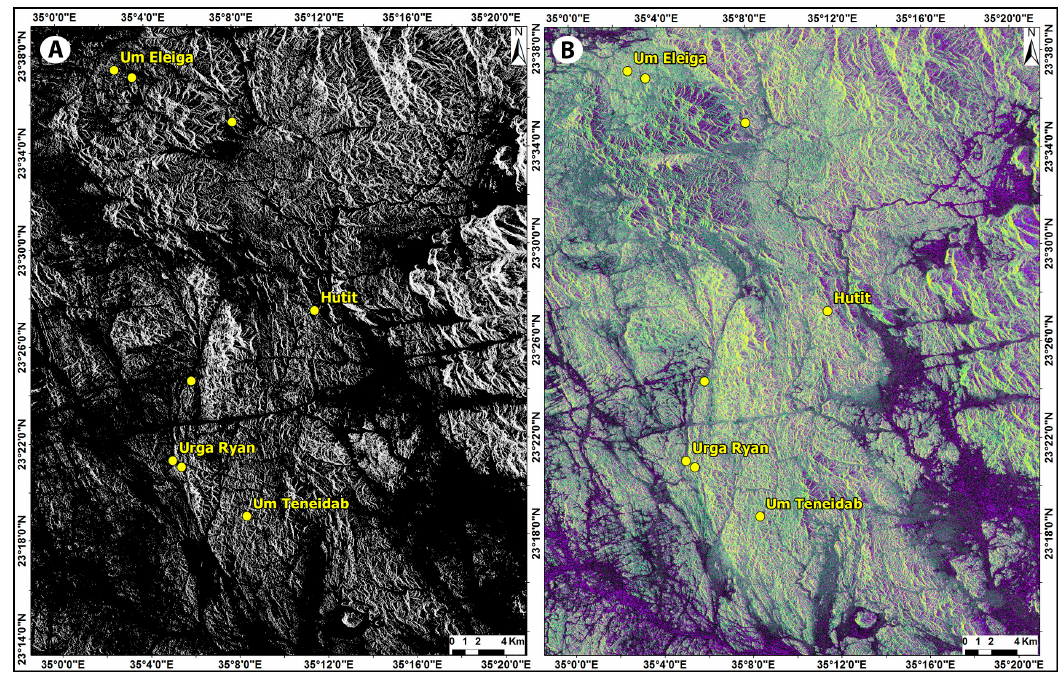
Figure 8. Structural mapping promoted using PALSAR and Sentinel-1B PCA data. ( A ) Grayscale image of PALSAR PC2; ( B ) FCC image of Sentinel-1 PCs (R: PC2, G: PC4, B: PC3).